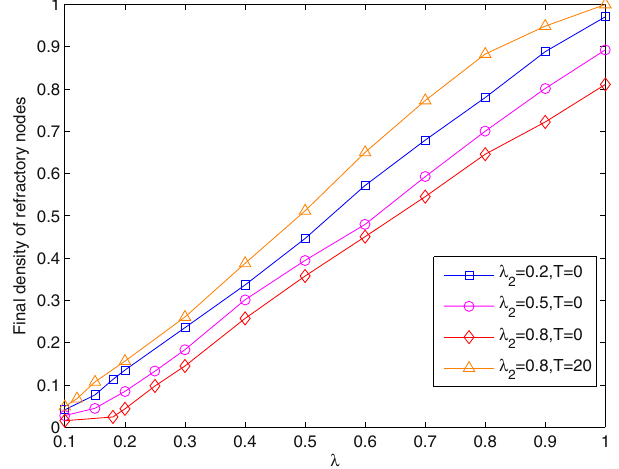
Figure 8. Final density of refractory nodes for information l 1 in the real network with the method of distracting node attention, δ = 0.5.